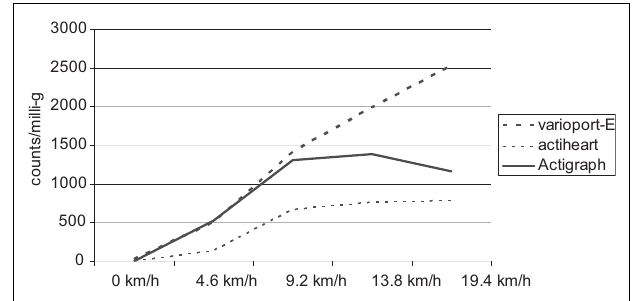
FIGURE 3 | Ceiling effects of actiheart ® and actigraph in comparison to varioport-E by increasing running